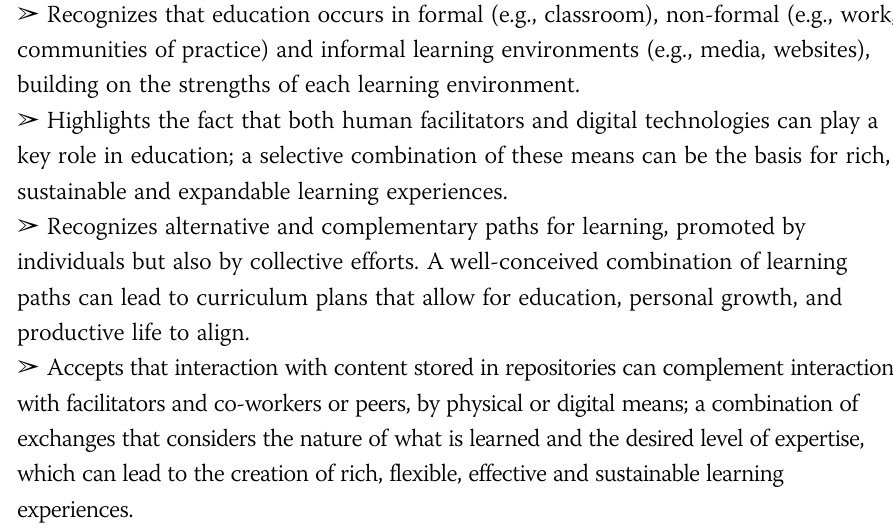
Table 1 Two lenses to look at dimensions of the blend Dimensions of the blend (Singh, 2003) Dimensions of the blend (Galvis, 2017a) Offline (face-to-face) and online (virtual) learning environments